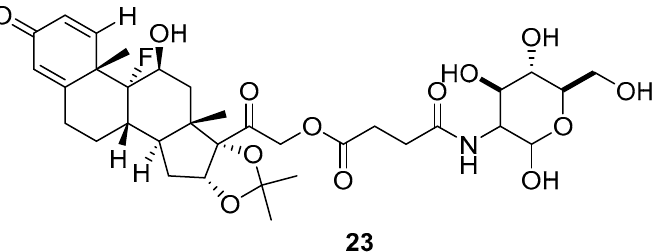
Figure 17. Triamcinolone acetonide-based gelators with a sugar moiety [55] .